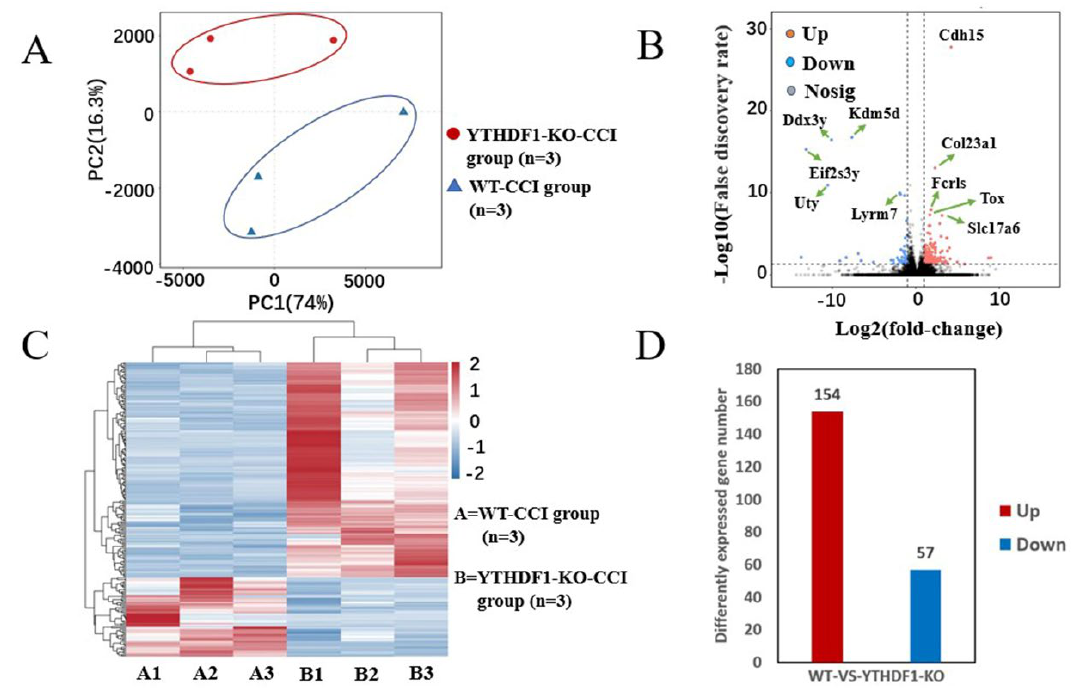
Figure 9. Different expression levels of mRNA between the YTHDF1-knockout group and the WT group after TBI. ( A ) Principal component analyses of the YTHDF1-knockout group and the WT group. The confidence ellipses of samples among YTHDF1-knockout and WT groups were separate from each other. ( B ) Volcano plot shows the markedly upregulated and downregulated mRNAs among YTHDF1-knockout and WT groups after TBI. ( C ) Heat map reveals the relative expression levels of the three YTHDF1-knockout samples and the three WT samples. ( D ) The expression levels of mRNA in YTHDF1-knockout mice. A total of 154 mRNAs had increased expression and 57 mRNAs decreased expression ( p < 0.05, log 2 FC > 1) in YTHDF1-knockout mouse cerebral cortex after TBI. Table 1. The top 20 differently expressed mRNAs based on p -value.